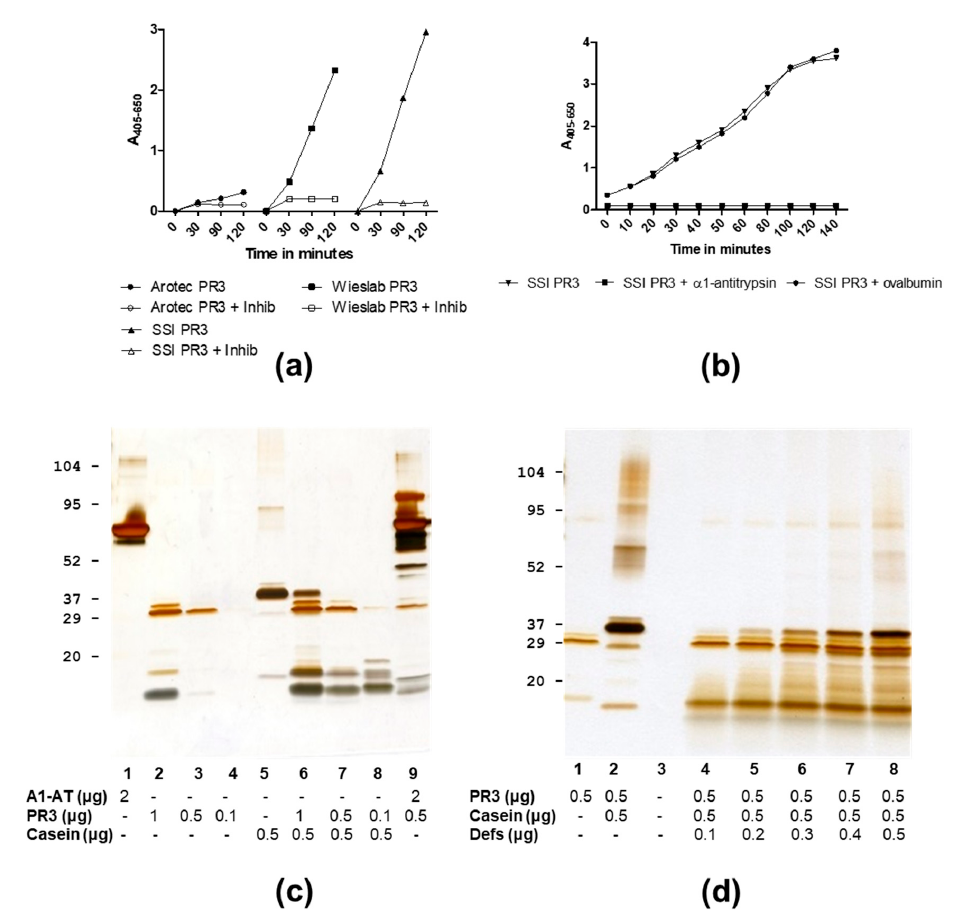
Figure 2. Proteolytic activity of PR3 preparations analysed by competitive inhibition assays and SDS-PAGE followed by silver staining. ( a ) Time-dependent hydrolysis of MeO-Suc-AAPV-PNA by Wieslab, SSI or Arotec PR3 with and without addition of inhibitor (MeO-Suc-AAPV-CMK). ( b ) Hydrolysis of MeO-Suc-AAPV-PNA by SSI PR3 with or without addition of α 1-antitrypsin or ovalbumin (4 µg/mL). ( c ) Incubation of casein with varying SSI PR3 amounts pr lane. ( d ) Incubation of casein with SSI PR3 and varying α -defensin amounts pr lane.